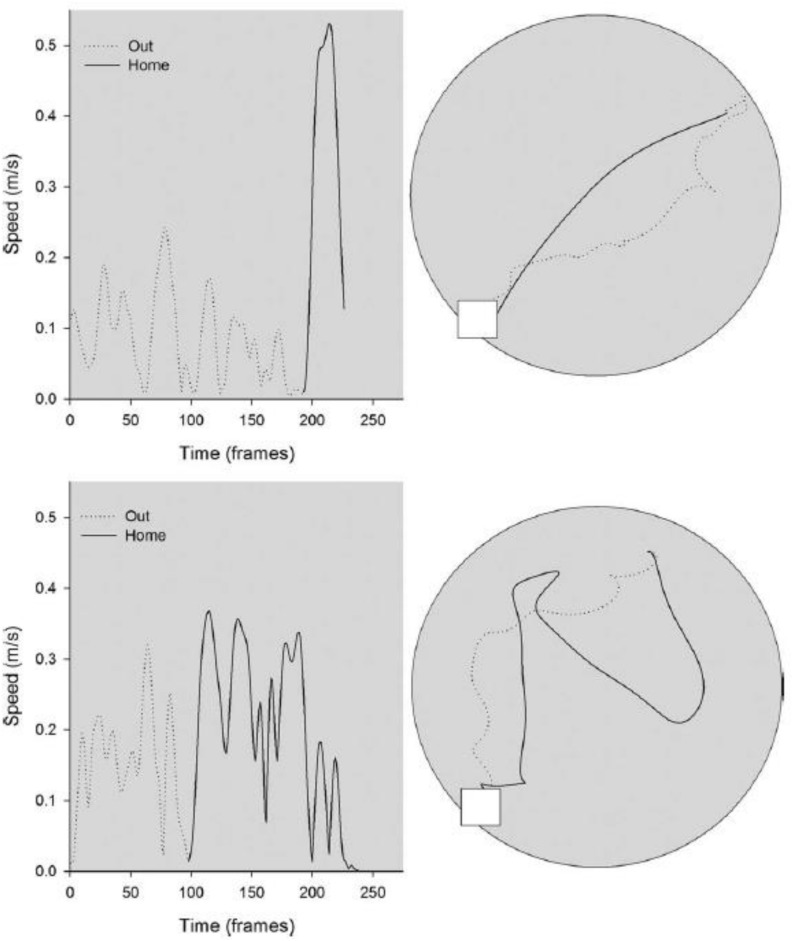
Kinematic (left) and topographic (right) characteristics are plotted for a representative control (top) and tilted mouse (bottom) on the homing task in darkness. The outward path (gray dashed line) is circuitous for both mice; the homeward segment (black line) is relatively direct for the control mouse, but is more circuitous for the tilted mouse. Reproduced from Yoder et al. (2015) with permission.